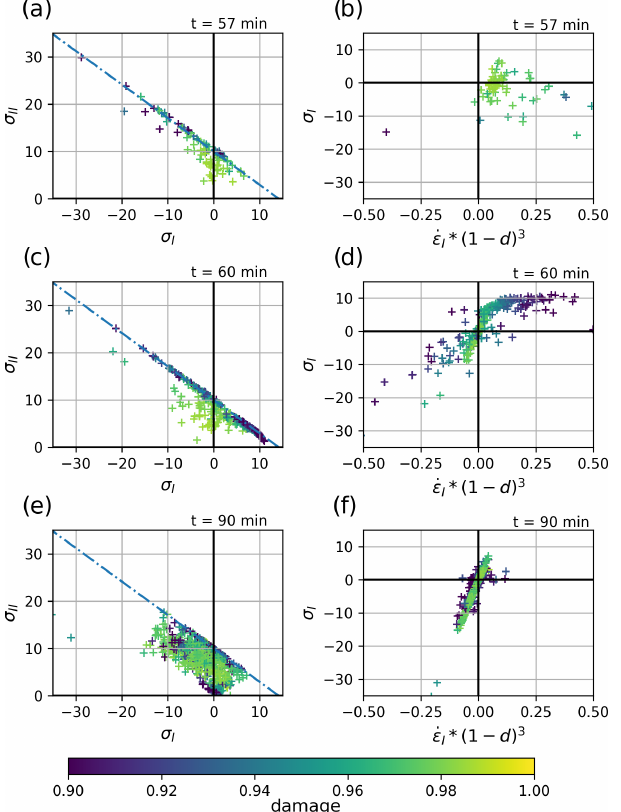
Figure 4. Scatter plots of local stress invariants ( σ I vs. σ II , in kNm − 1 , left column) and of the normal stresses and scaled strain rate invariants ( σ I vs. ( 1 − d) 3 ˙ (cid:15) II , right column) in heavily damaged ( d > 0 . 9) grid cells, at t = 57min (during the fracture development, top row), t = 60min (a few minutes after the fracture, middle row) and t = 90min ( ∼ 30min after the fracture, bottom row). Colour in- dicates the local damage. The strain rates are normalized to account for the non-linear dependency of the viscosity η on the damage pa- rameter. The gradual alignment of the points in the σ I vs. ( 1 − d) 3 ˙ (cid:15) II diagram indicates the development of a linear–viscous stress–strain relationship over time.